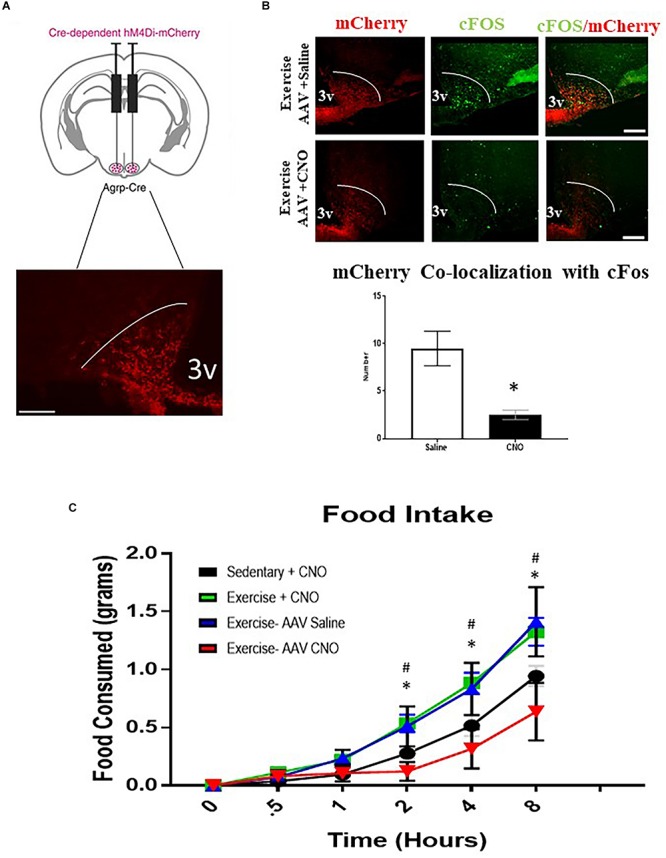
AgRP neuron inhibition abolishes acute exercise induced food intake. (A) Top, targeting scheme for hM4Di-mCherry. Bottom, localization of hM4Di-mCherry with the anatomical location of NPY/AgRP neurons in the ARC. (B) Immunofluorescence and quantification of mCherry positive and cfos-expressing cells in the ARC from AAV CNO and AAV Saline groups immediately after a bout of acute exercise. (C) Cumulative food intake over an 8-hour period immediately after the exercise or sedentary conditions. # indicates significance between Exercise CNO and Sedentary CNO groups (p < 0.05); * indicates a significant difference between Exercise AAV Saline and Exercise AAV CNO groups (p < 0.05) (N = 6 male mice per group). (I.P. CNO and saline injections of 0.3 mg/kg of body weight were applied 30 min prior to exercise). Bar graphs show Mean + SEM. 3V: third ventricle, scale bars represent 50 μm.